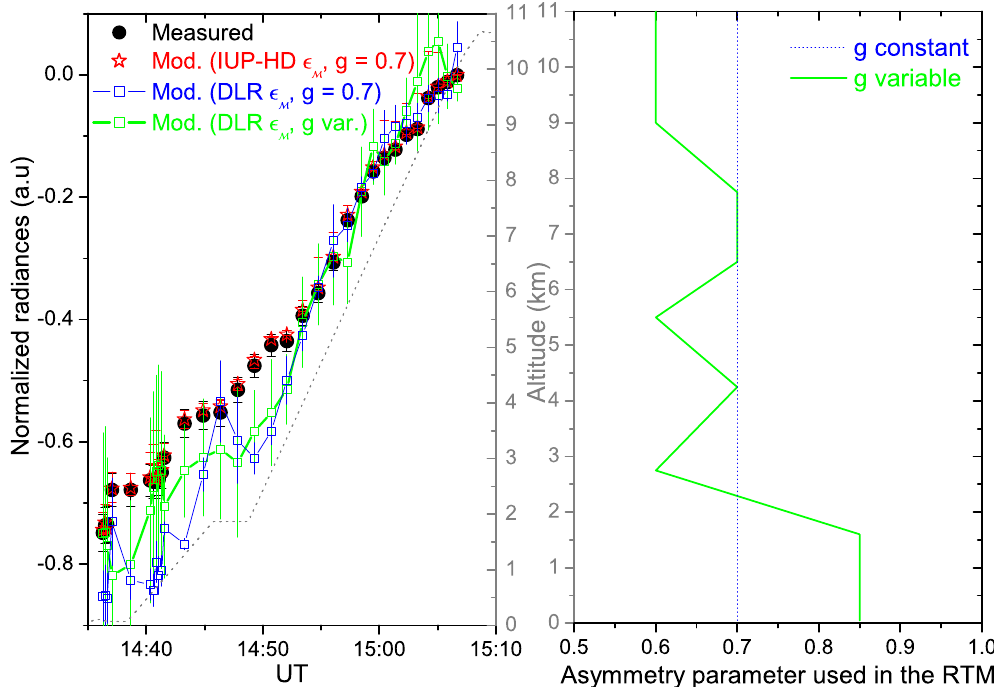
Fig. 6. (Left) Sun normalized radiances measured and modeled during the 14:30UT ascent (the dotted line represents the flight track). Measured radiances (at 353nm) are shown in black. At 353nm and 79% ground albedo, radiances are modeled considering different E M (refer to Fig. 5) and asymmetry parameter scenarios. Red: IUP-HD E M with g = 0.7. Blue: DLR E M with g = 0.7. Green: DLR E M with variable g . Error bars of all modeled radiances include their wavelength dependency (349–360.8nm). In addition, a ground albedo uncertainty of 20% is considered for the DLR radiances. (Right) Profiles of the aerosol asymmetry parameter considered for the RT studies ( g within the range of 0.6–0.85 as reported for the Arctic, e.g., Lampert et al.,